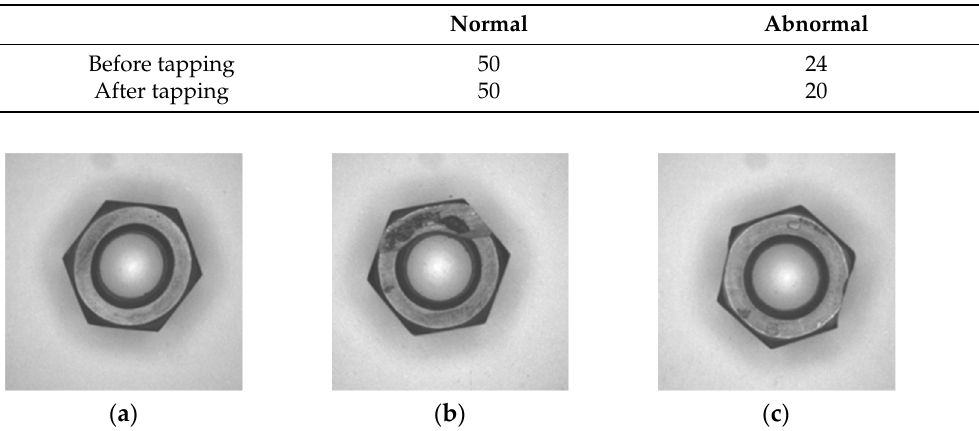
Table 2. Data collection .